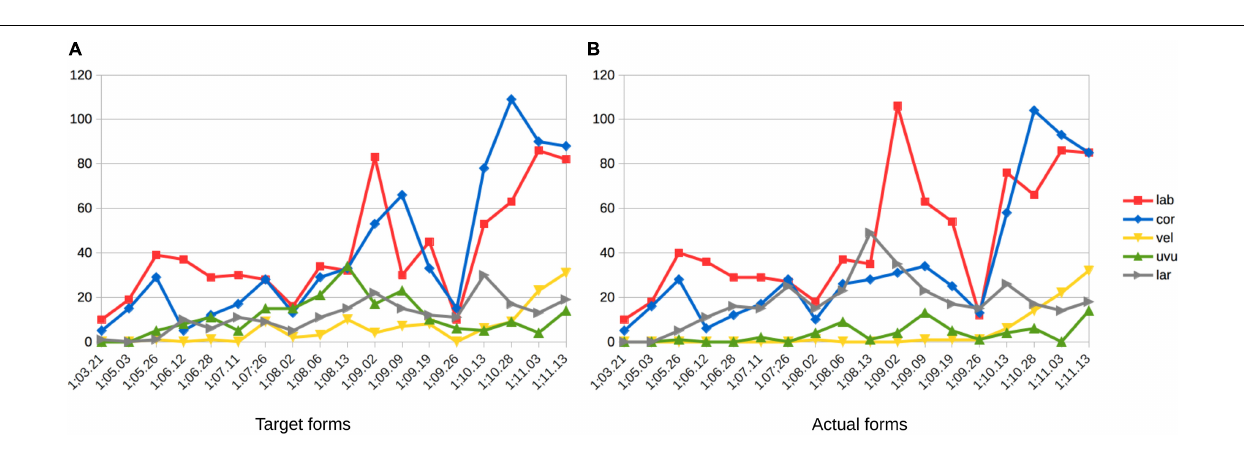
FIGURE 7 | Wiglaf’s word-initial places of articulation (token) between 1;03.21 and 1;11.13. (A) Target forms. (B) Actual